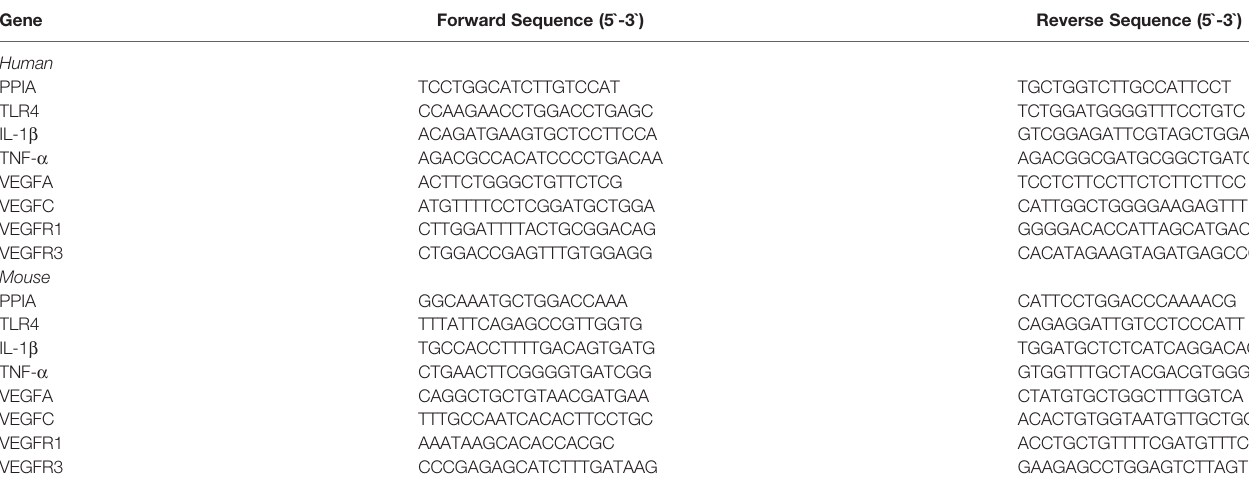
TABLE 1 | The sequence of human and mouse primers in